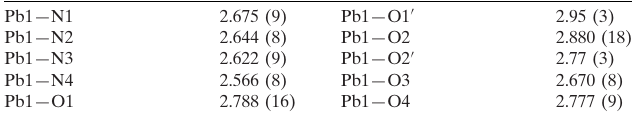
Selected bond lengths (A˚ ).